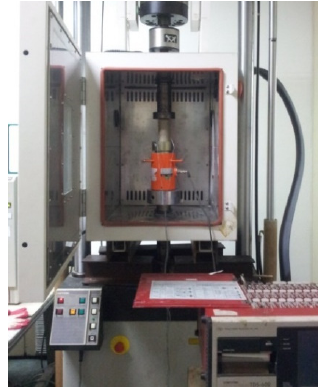
Figure 1. Test setup for determining the modulus of elasticity.